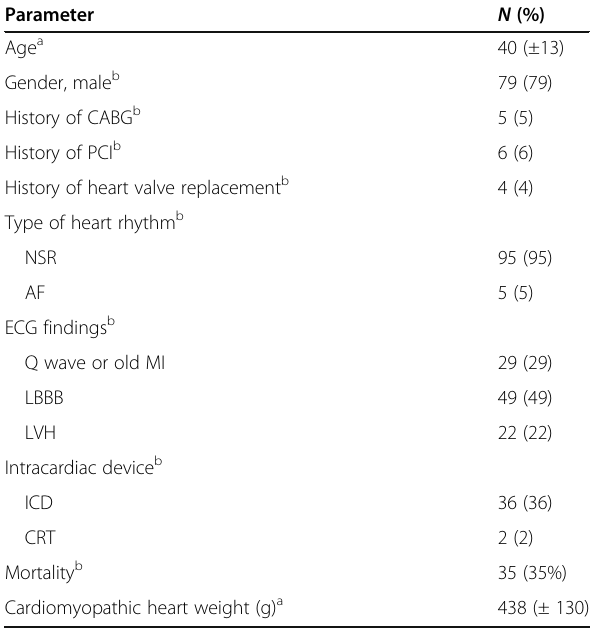
Table 1 Demographic and clinical features of